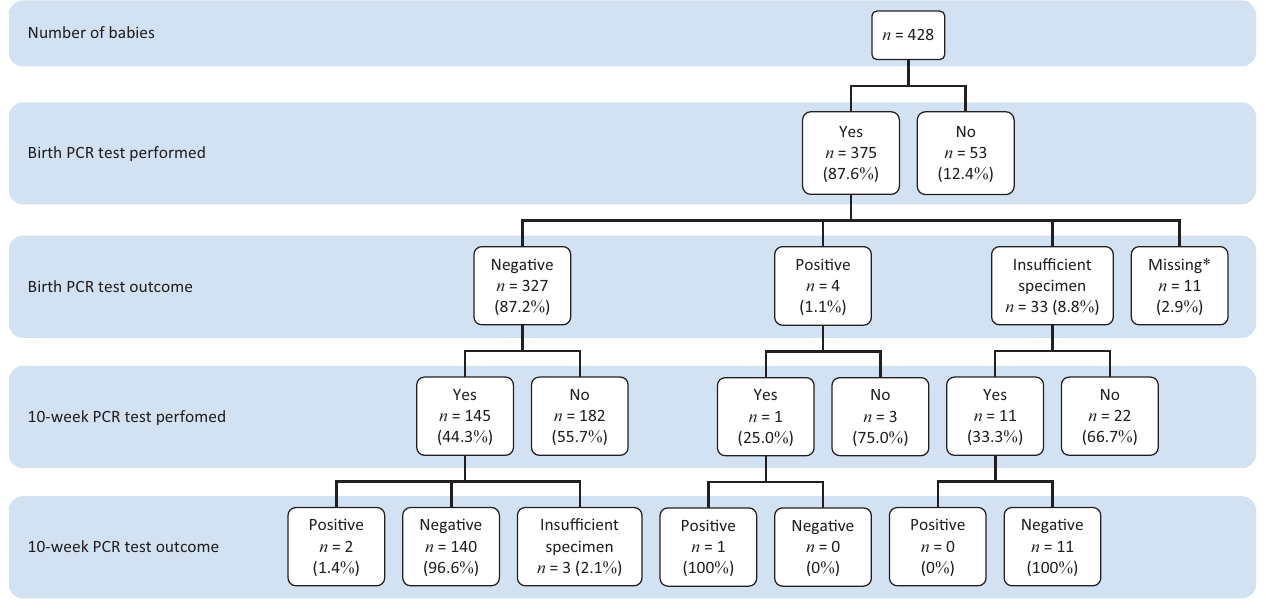
FIGURE 1: Birth and 10-week polymerase chain reaction testing of HIV-exposed